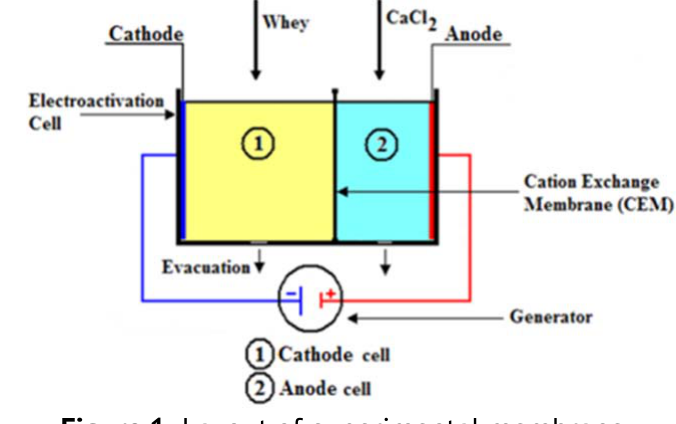
Figure 1. Layout of experimental membrane